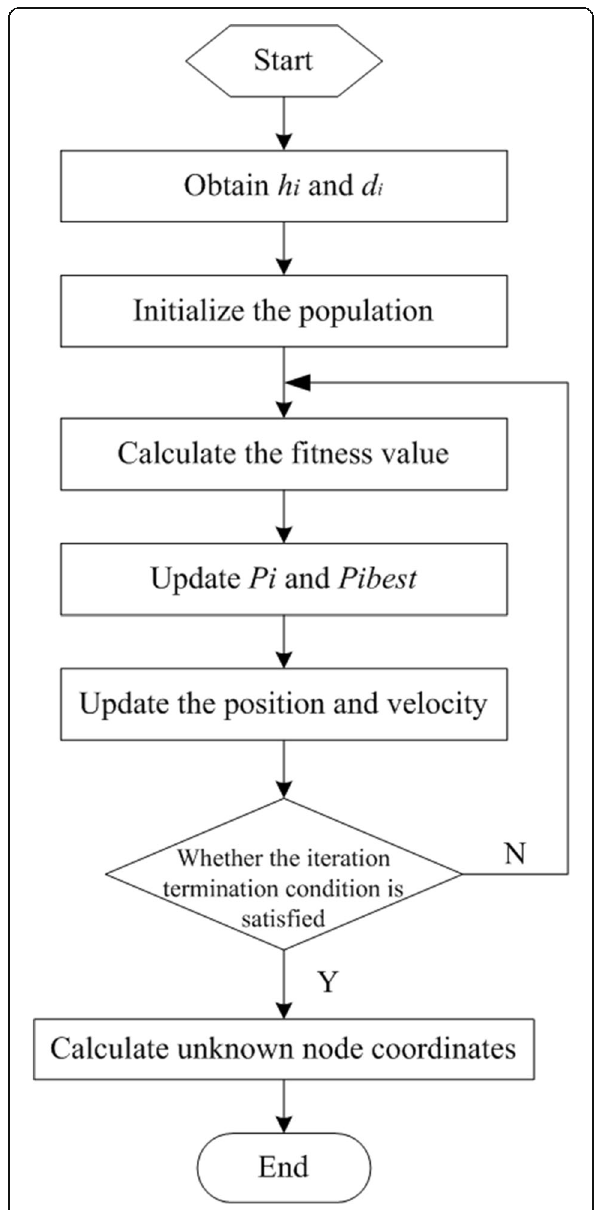
Fig. 4 Flow chart of the DV-Hop algorithm based on improved